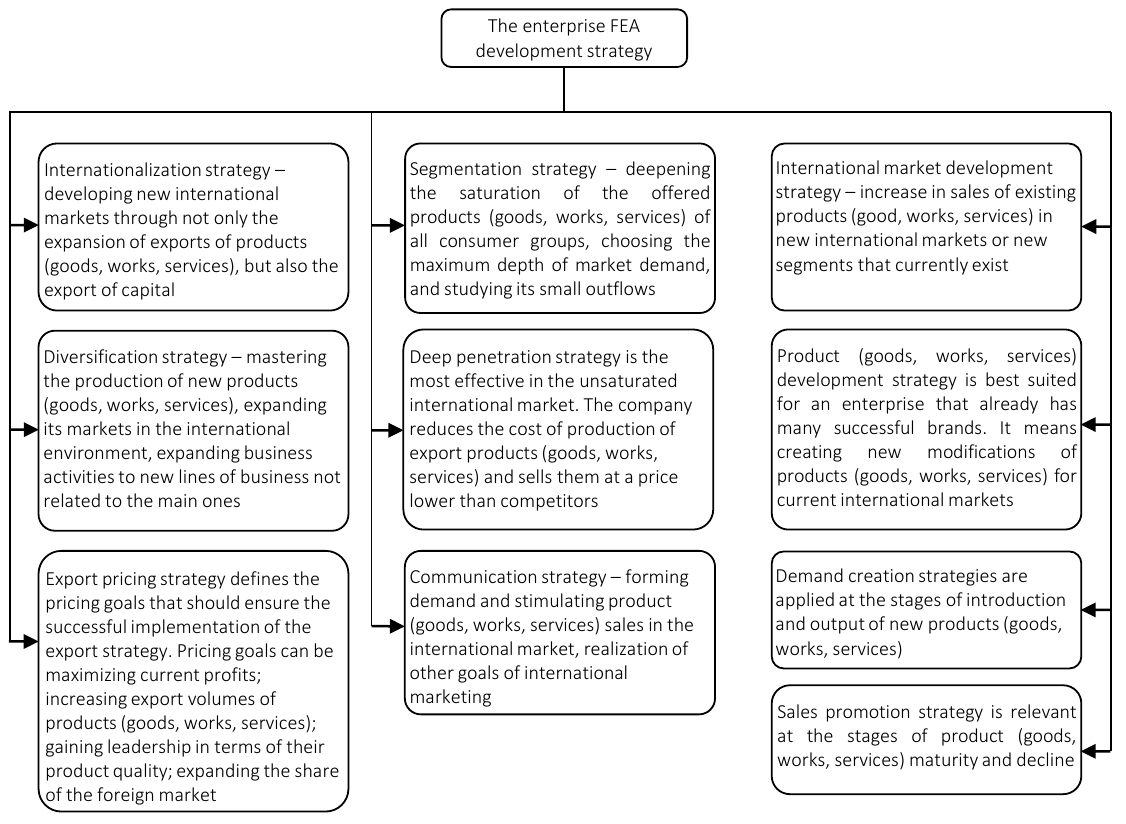
Figure 1. Types of strategies for the enterprise FEA